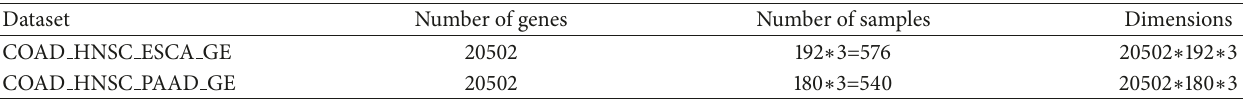
Table 1: Experimental